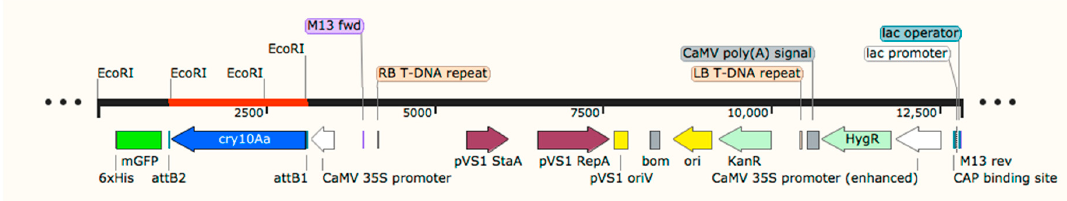
Figure 1. Schematic representation of the plasmid pMDC85 / cry10Aa . The 12,838 bp-long plasmid consists of the cry10Aa gene under 2XCaMV35S (cauliflower mosaic virus 35S promoter with a consistsofthe cry10Aa geneunder2XCaMV35S(cauliflowermosaicvirus35Spromoterwithaduplicated duplicated enhancer region) and 3´NOS (nopaline synthase terminator); HygR (hygromycin enhancer region) and 3 (cid:48) NOS (nopaline synthase terminator); HygR (hygromycin phosphotransferase) phosphotransferase) gene ( hph ) under 2XCaMV35S and 3´NOS terminator, mGFP (modified green gene ( hph ) under 2XCaMV35S and 3 (cid:48) NOS terminator, mGFP (modified green fluorescent protein) fluorescent protein) under 2XCaMV35S promoter and 3´NOS terminator. 6xHis (6x histidine affinity under 2XCaMV35S promoter and 3 (cid:48) NOS terminator. 6xHis (6x histidine a ffi nity tag); attB1-B2 (mutant tag); attB1-B2 (mutant version of att B); RB (right border repeat from nopaline C58T-DNA); pVS1 version of att B); RB (right border repeat from nopaline C58T-DNA); pVS1 StaA (stability protein StaA (stability protein from Pseudomonas plasmid pVS1); pVS1 RepA (replication protein from from Pseudomonas plasmid pVS1); pVS1 RepA (replication protein from Pseudomonas plasmid pVS1); Pseudomonas plasmid pVS1); Bom (bases of mobility region from pBR322); Ori (high-copy-number Bom (bases of mobility region from pBR322); Ori (high-copy-number ColE1 / pMB1 / pBR322 / pUC origin ColE1/pMB1/pBR322/pUC origin of replication); KanR (aminoglycoside phosphotransferase aphA-3 , of replication); KanR (aminoglycoside phosphotransferase aphA-3 , which confers kanamycin resistance); which confers kanamycin resistance); LB T-DNA repeat (left border repeat from nopaline C58 LB T-DNA repeat (left border repeat from nopaline C58 T-DNA); CaMV poly(A) signal (cauliflower T-DNA); CaMV poly(A) signal (cauliflower mosaic virus polyadenylation signal); CAP binding site mosaic virus polyadenylation signal); CAP binding site ( E. coli catabolite activator protein); lac promoter (three segments) promoter for the E. coli lac operon; lac operator (laccase repressor encoded by lacI